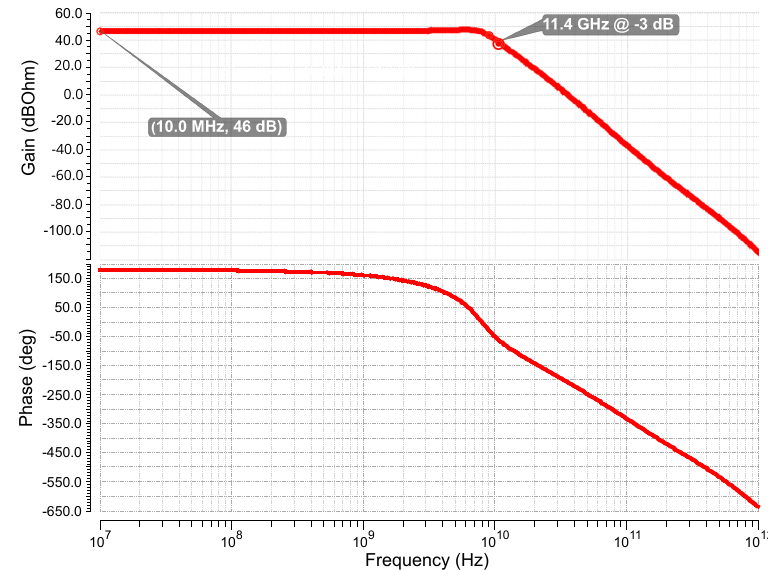
Figure 10. Post-layout simulated frequency response of the proposed TIA. Table 1. Cutoff frequency and current dissipation comparison of TIA. Current Dissipation Cutoff Frequency in TIA Core